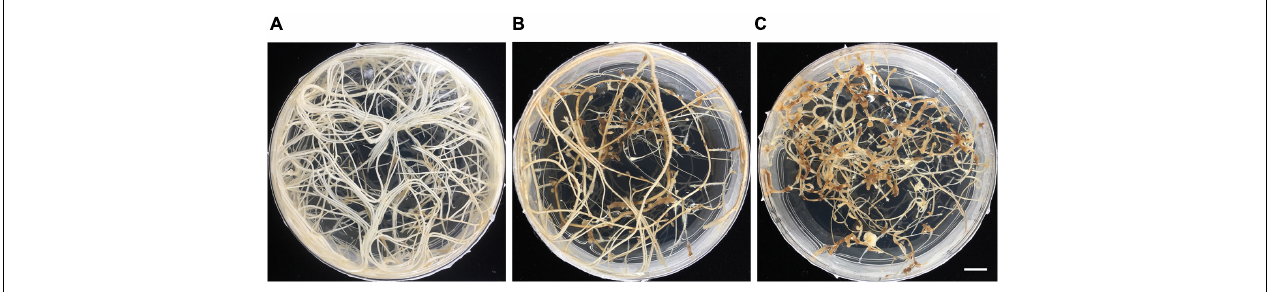
FIGURE 5 | Deterioration of hairy root growth under prolonged culture in vitro . (A) Two-month-old hairy roots. (B) Five-month-old hairy roots. (C) Six-month-old hairy roots. Scale bar = 1 cm.